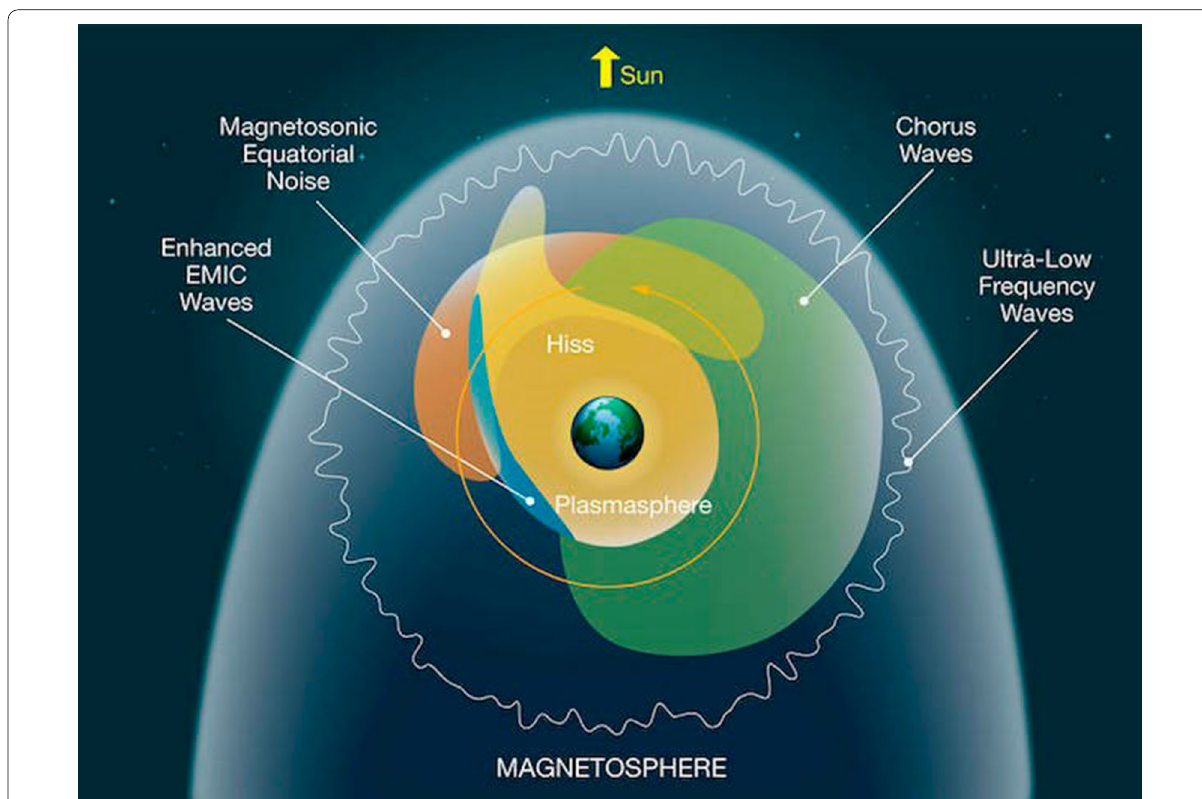
Fig. 10 Schematic diagram showing many of the wave modes that affect energetic electrons in the Earth’s radiation belts (courtesy of NASA; adapted from Summers et al.